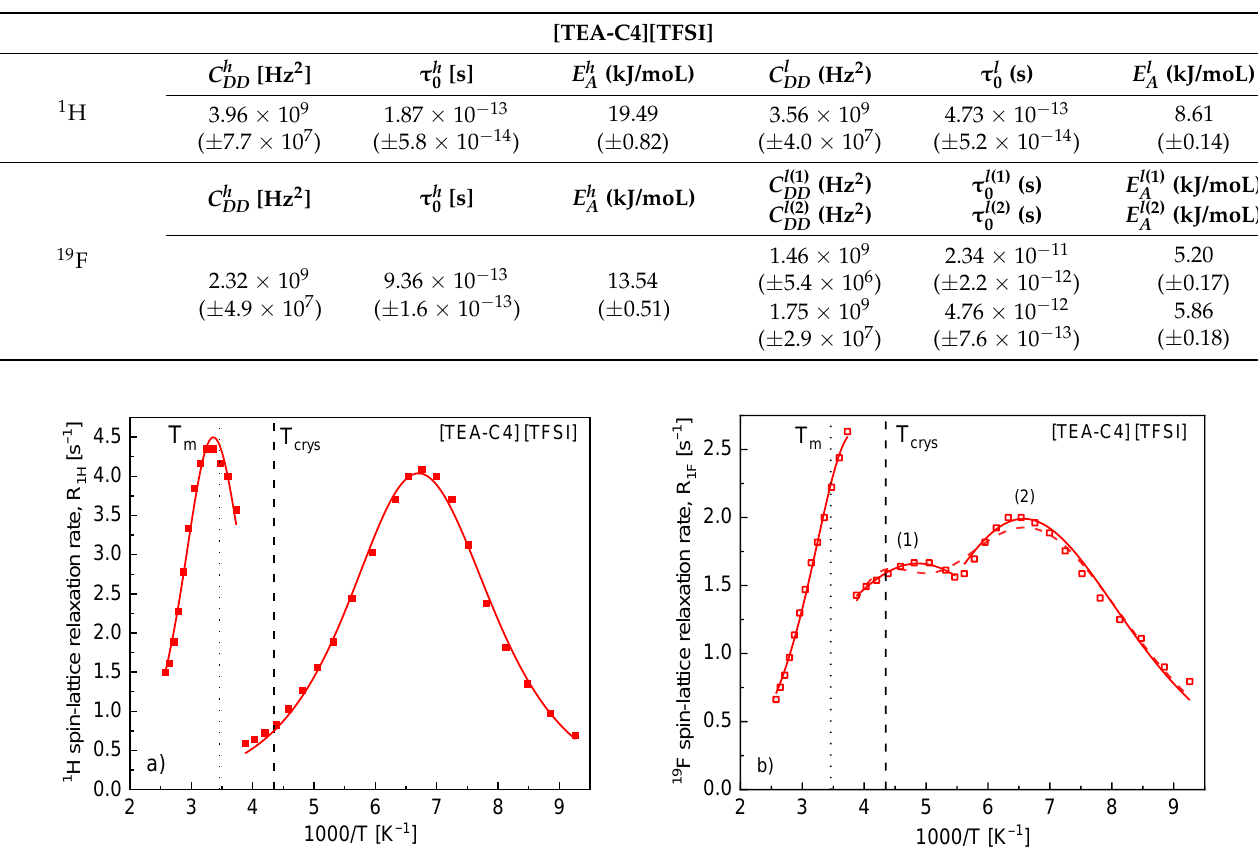
Figure 2. 1 H ( a ) and 19 F ( b ) spin-lattice relaxation rates versus reciprocal temperature for [TEA-C4] [TFSI]. Solid lines—fits with parameters collected in Table 1, dashed red line—fit with parameters give in the text, vertical lines indicate phase transition temperatures ( T crys = 229.89 K and T m = 289.10 K denote the crystallization and melting temperatures [26], respectively).